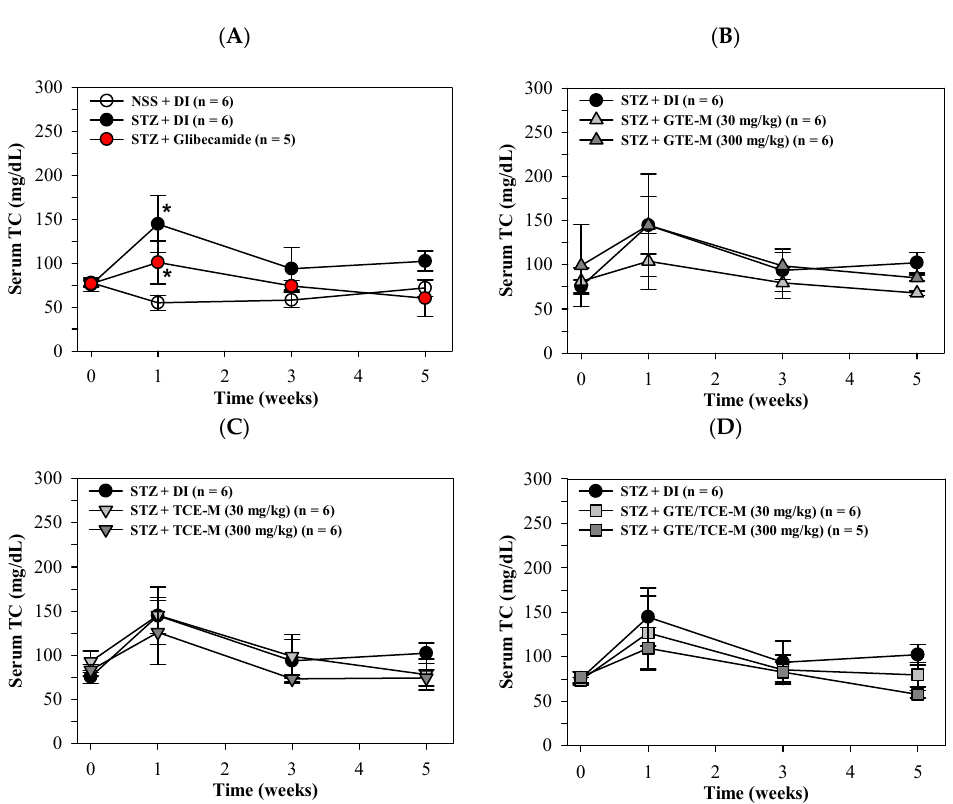
Figure 4. Total cholesterol (TC) levels of serum in STZ-induced rats. Wistar rats were intraperitoneally injected with STZ (65 mg/kg, single dose) to induce diabetic mellitus or NSS (control) and orally administered with DI, glibenclamide (5 mg/kg) ( A ), GTE-M ( B ), TCE-M( C ) or GTE/TCE ( D ) macaroni products (30 and 300 mg/kg each) every day for four weeks. Data are expressed as mean ± SD values. Accordingly, * p < 0.05 when compared with NSS + DI at the same time interval. Abbreviations: DI = deionized water, GTE-M = green tea extract-fortified macaroni, GTE/TCE-M = green tea extract and turmeric curcumin extract-fortified macaroni, NSS = normal saline solution, STZ = streptozotocin, TC = total cholesterol, and TCE-M = turmeric curcumin extract-fortified macaroni.